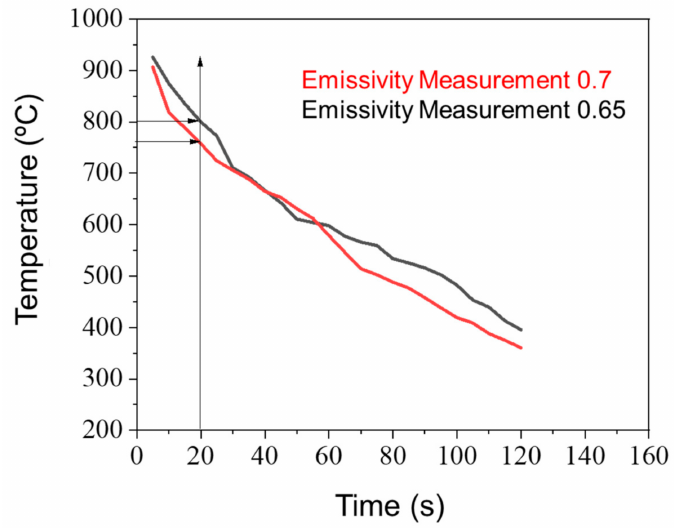
Figure 2. Emissivity measurement (0.65 and 0.7) of air-cooling curve of the NiTi alloy samples after soaking on the heat treatment at 950 ◦